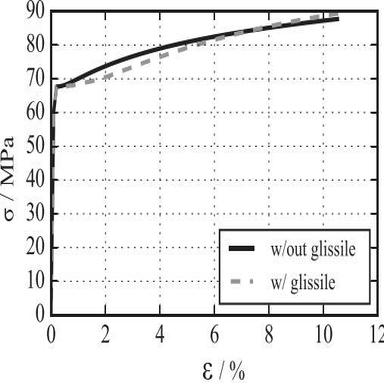
Simulated stress-strain response obtained for the original dislocation based constitutive model and for the advanced model considering glissile junction formation. Figure adopted from with permission from KIT Scientific Publishing. Licensed under CC BY-SA 4.0.